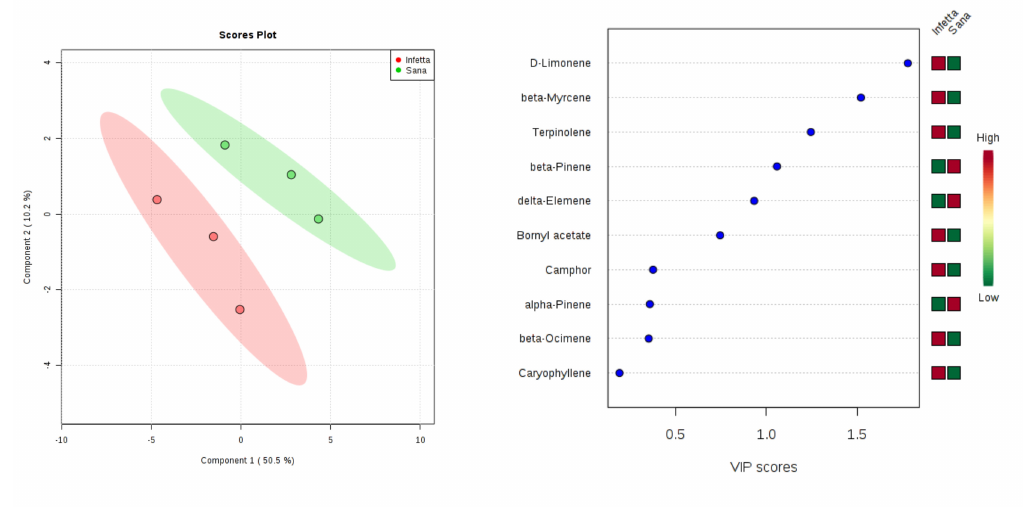
Figure 13. Partial least squares discriminant analysis applied to the Sampling #4 (PROCE-1) in Canolo. Parameters and symbols as in Figure